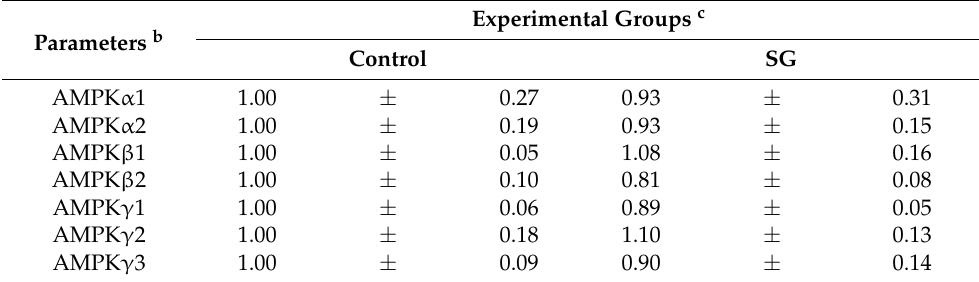
a Data are expressed as the mean ± SEM ( n = 7–8/group). b AMPK, adenosine monophosphate-activated protein kinase. c SG, superliv